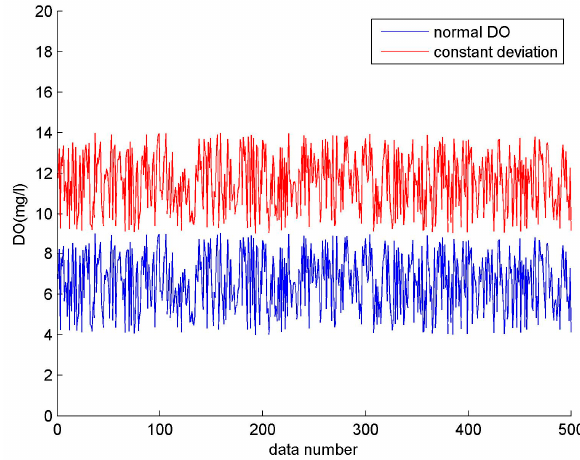
Figure 5. Constant deviation (DO).